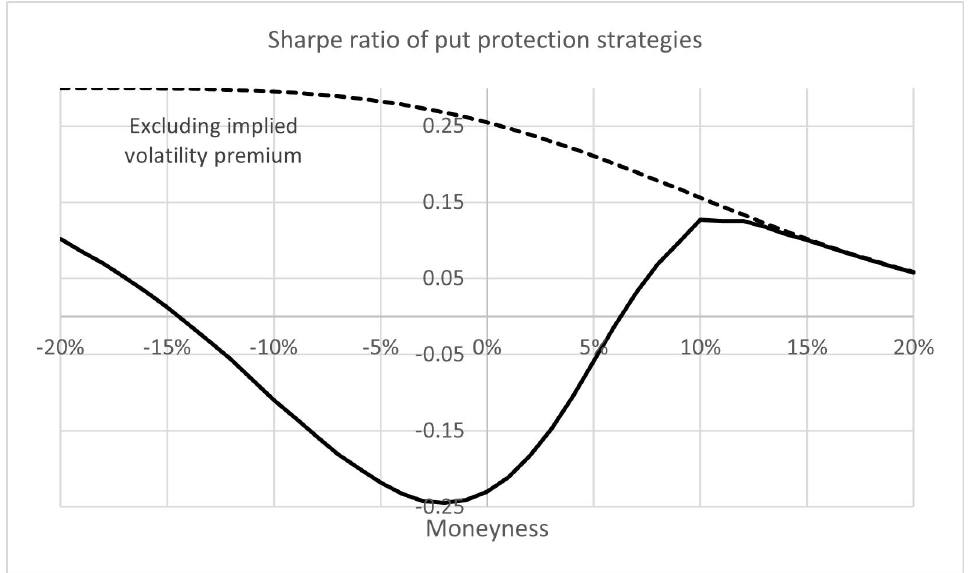
Figure 12. The Sharpe ratio for an underlying asset with an overlaid put protection strategy for a range of strike prices. The dotted line assumes the implied volatility is equal to the underlying asset volatility. The solid line includes the implied volatility premium in the price of the